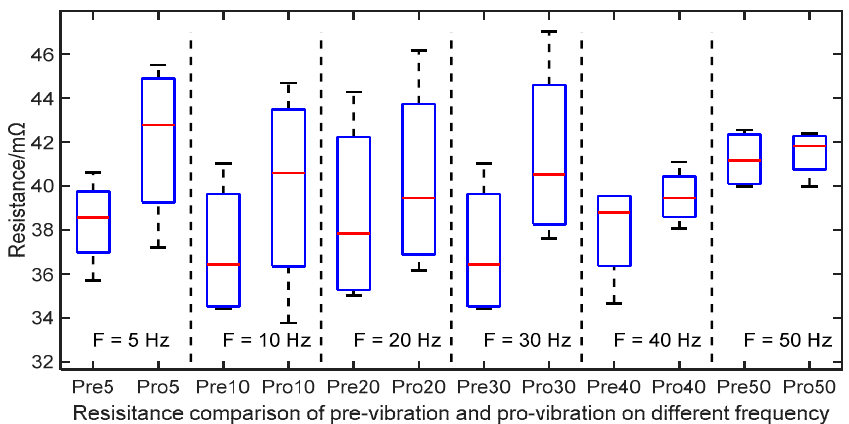
Figure 12. The box charts of batteries samples under vibration conditions with vibration frequency of 10 Hz/20 Hz/30 Hz/40 Hz/50 Hz.